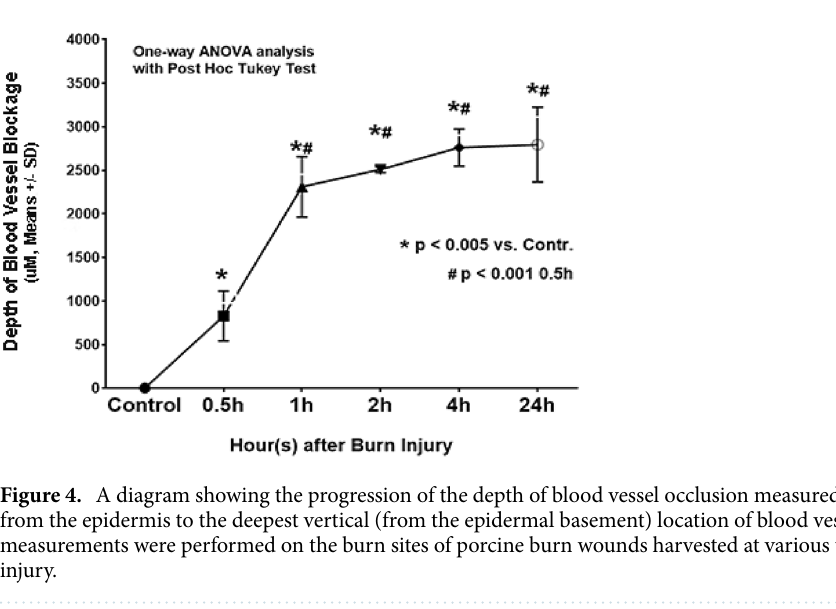
full blood vessel occlusion in the middle of the dermis, the bottom of the dermis as well as the upper portion of hypodermis in the burn sites as time progress. Measurements of the depth of blood vessel occlusion in the burn sites showed increased progression of the brass comb burn wound (Table 1). This depth increased at 30 min (p < 0.005 vs control), reached a significantly higher level at 1 h after burn (p < 0.0001) that continued to increase up to 2 h (p < 0.005). The depth of blood vessel occlusion increased slightly from 2 to 4 h then to 24 h, but these increases were not significant (p > 0.05) compared to the values measured at 1 h or 2 h. Graphical representation of the depth of blood vessel occlusion, depicted in Fig. 4, shows a 3-phases progression: 1- an immediate response within 30 min, 2- a rapid progression from 0.5 h to 2 h, and 3- a slow progression from 2 to 24 h after the initial injury (Figs. 2, 3, and 4). Endothelial cell death. Histochemistry features. Analysis of control skin and unburned interspaces of the burn wounds shows a strong positive vimentin IHC-P staining of uninjured blood vessels from the upper dermis (just beneath the basement of the epidermis, Figs. 5A and 6A) to the hypodermis (Fig. 5A). In the burn sites, clear negative labeling of blood vessels was observed from the dermis to the hypodermis depending on the time point of sample collection (Figs. 5B–F and 6B–F), making vimentin IHC-P a useful marker to monitor the progression of endothelial cell death after-burn. Although negative vimentin-staining of blood vessels is not direct evidence of endothelial cell death, the negative staining means that the specific antibody did not recognize the binding structures of the antigen due to structural changes such as degeneration, or disorganization, which generally means irreversible structure change or cell death. Hematoxylin and eosin (H&E) stained sections from the burn sites showed increased nuclear condensation in the epithelial and endothelial cells, indicative of dead cells. Nuclear condensation was not observed in the interspace of the same section, 1 h after thermal burn (100 °C for 30 s) (data not shown). Progression of endothelial cell death. As shown in Figs. 5 and 6 and quantified in Table 1, the depth of endothe- lial cell death increased significantly by 30 min after burn (p < 0.005 vs control) and stayed at the middle dermis through 2 h. Endothelial cell death continued to increase significantly at 4 h (p < 0.003 vs 0.5, 1, and 2 h), and 24 h (p < 0.03 vs 4 h). Figures 5 and 6 demonstrate the temporal progressive vertical loss vimentin-staining